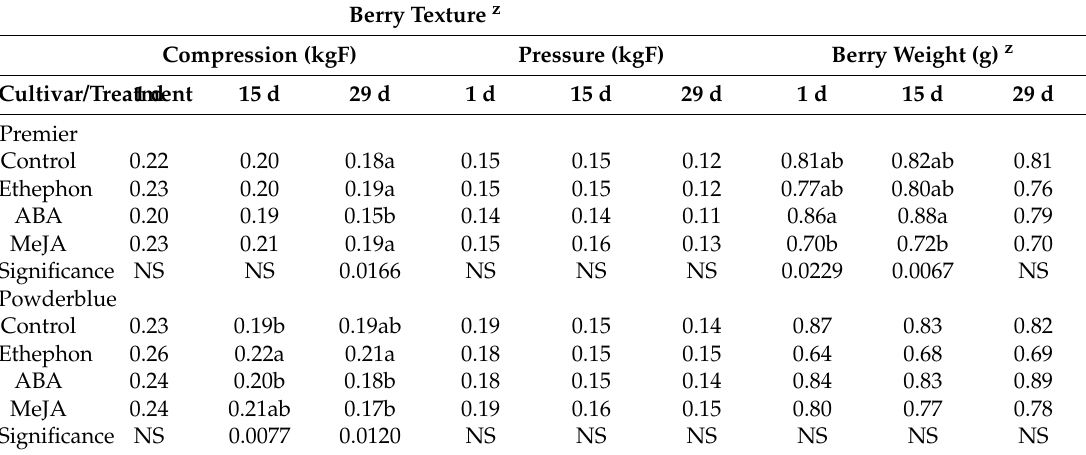
Table 3. Effect of preharvest treatment with water (control), ethephon, abscisic acid (ABA), and methyl jasmonate (MeJA) on fruit texture and weight sampled at 1, 15, and 29 days of cold storage at 4 ◦ C in Premier and Powderblue